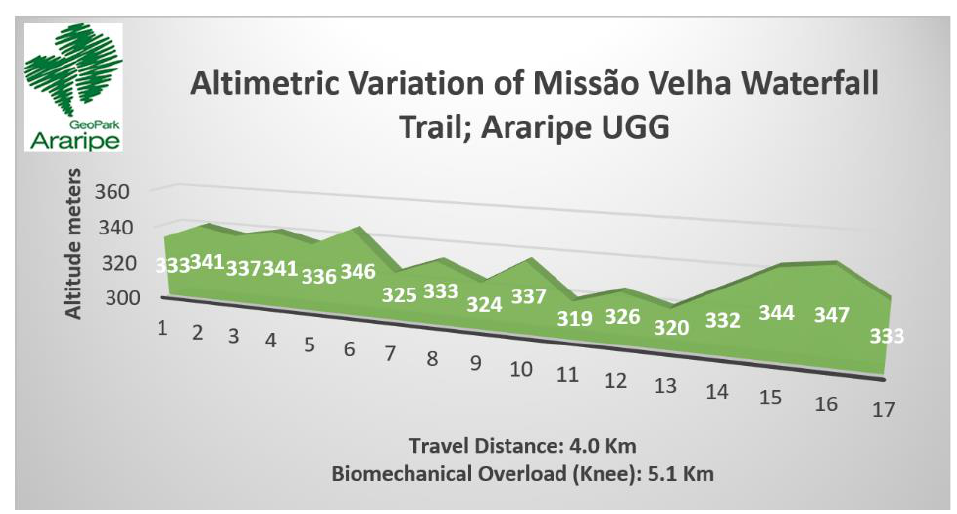
Figure 13. Altimetric Variation of Missão Velha Waterfall trail; Araripe UGG. Source: Research Collection. Based on the indicators of altimetric variation (positive and negative) and the distance